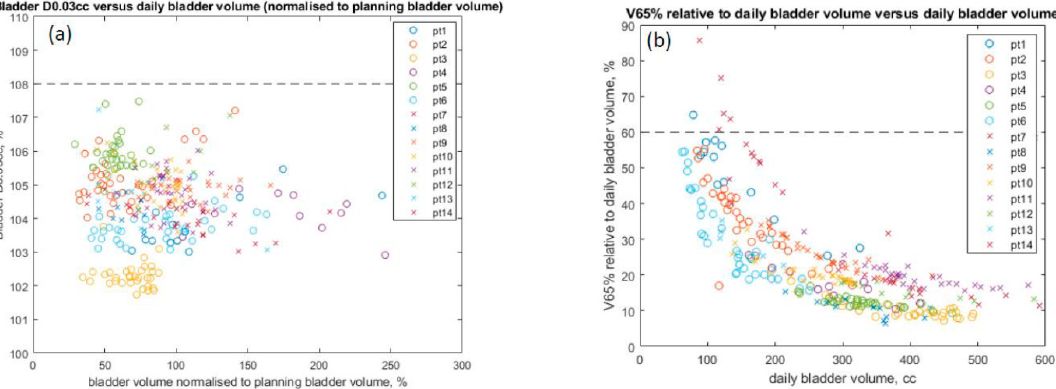
Figure 3. ( a ) Maximum bladder dose (0.03 mL) versus daily bladder volume. Maximum accepted D0.03mL of 108% is indicated with dashed black line. ( b ) V65% relative to daily bladder volume versus daily bladder volume. Constraint of V65% <60% is indicated by the dashed black line. Patients 1–6 (circle) use no endorectal balloons. Patients 7–14 (crosses) use endorectal balloons.